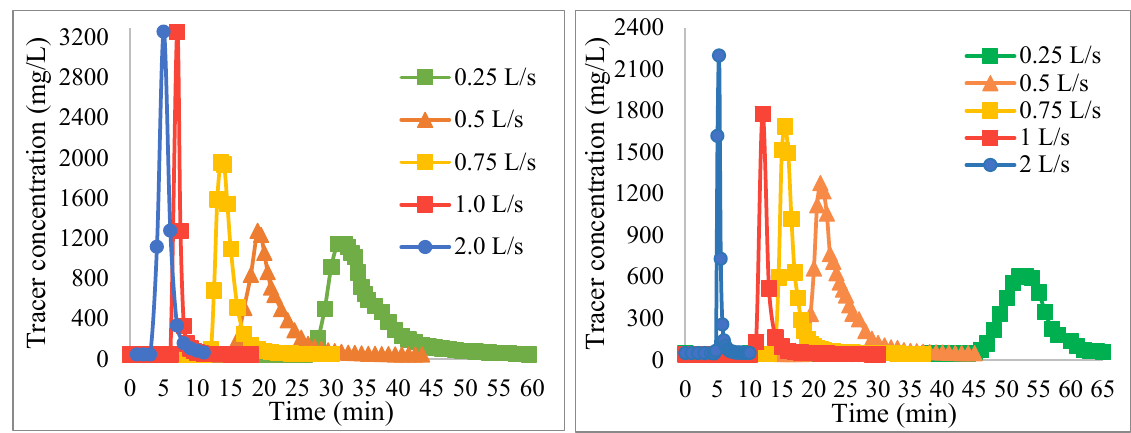
Figure 4. Tracer distribution curves in the HTF effluent.